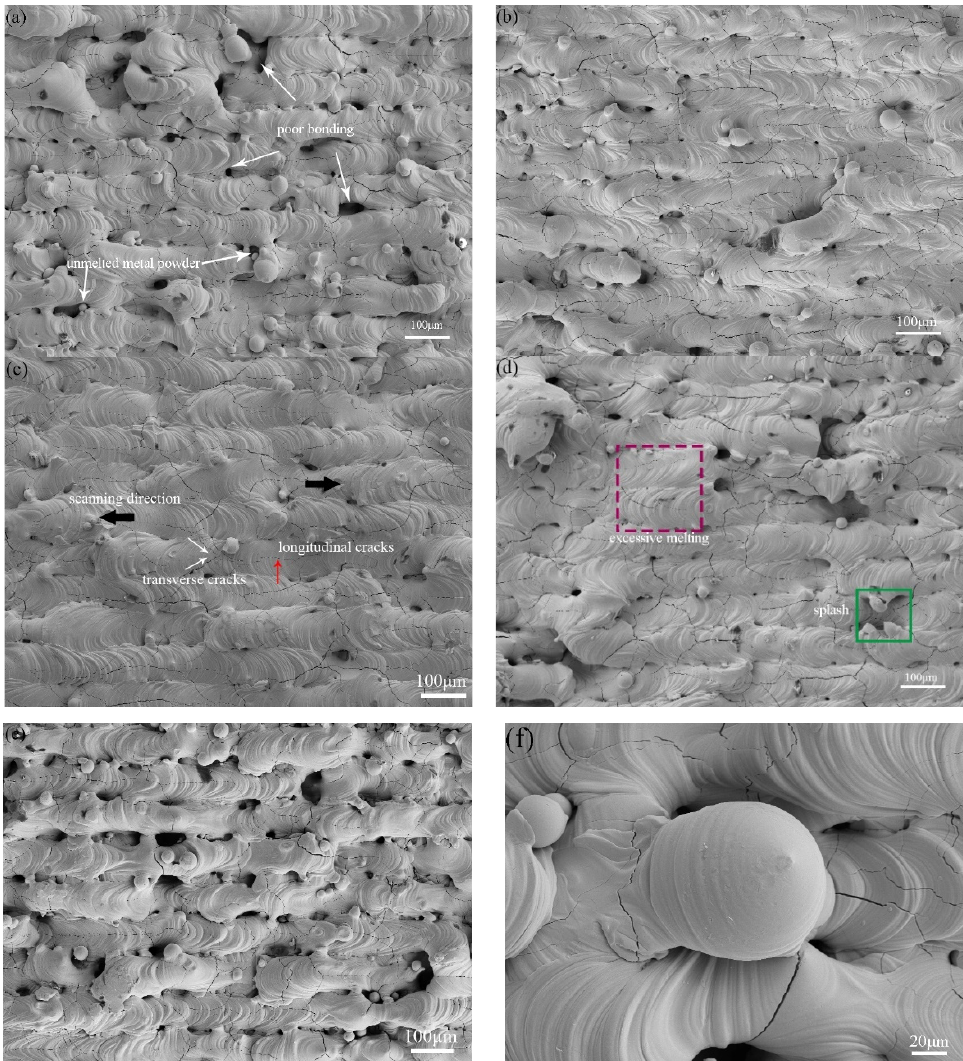
Figure 5. The melt track of the as-built Mo SLM parts under different zone: ( a ) zone A, LED = 0.36 J/mm, ( b ) zone B, LED = 0.64 J/mm, ( c ) zone C, LED = 0.51 J/mm, overlap = 20%, ( d ) zone D, LED = 0.80 J/mm, ( e ) LED = 0.51 J/mm, overlap = 0%, ( f ) balling phenomenon .